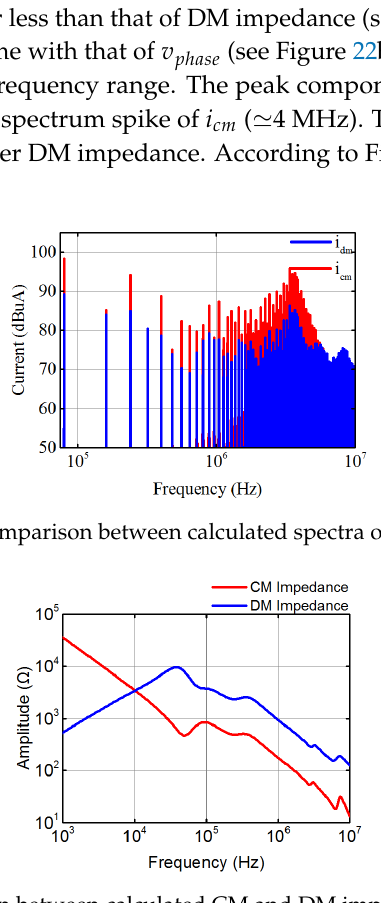
Figure 24. Comparison between calculated CM and DM impedances of the